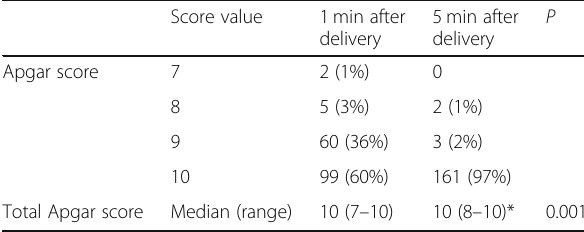
Table 5 The Apgar score for the spinal group babies, excluding twins Score value 1 min after